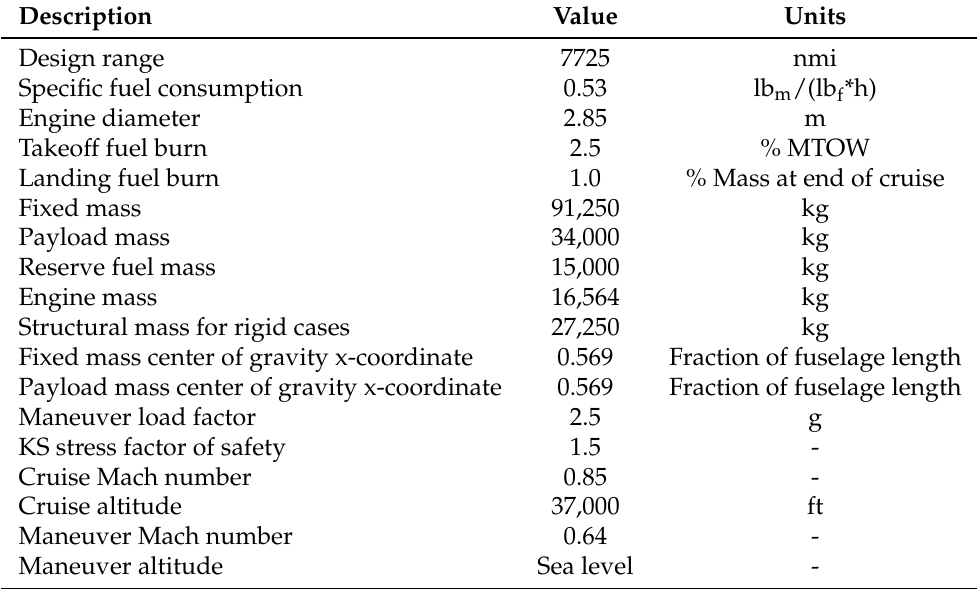
Table 3. Fixed parameters used for the objective and constraints. Note that engine diameter and mass (based on Boeing 777-200ER/GE90) are only used in the pitching moment constraints (by means of thrust and